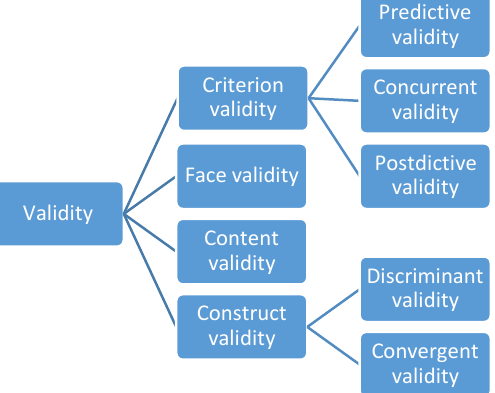
Fig. 2. Subtypes of various forms of validity tests.